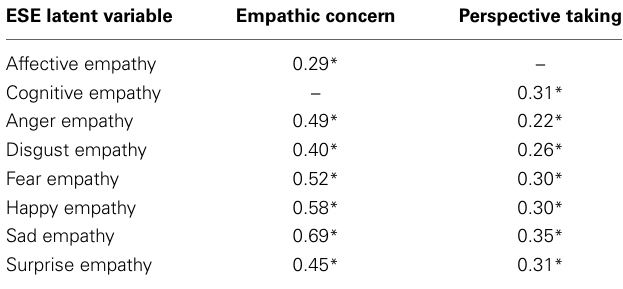
Table 5 | Correlation coefficients between the IRI subscales and the ESE latent